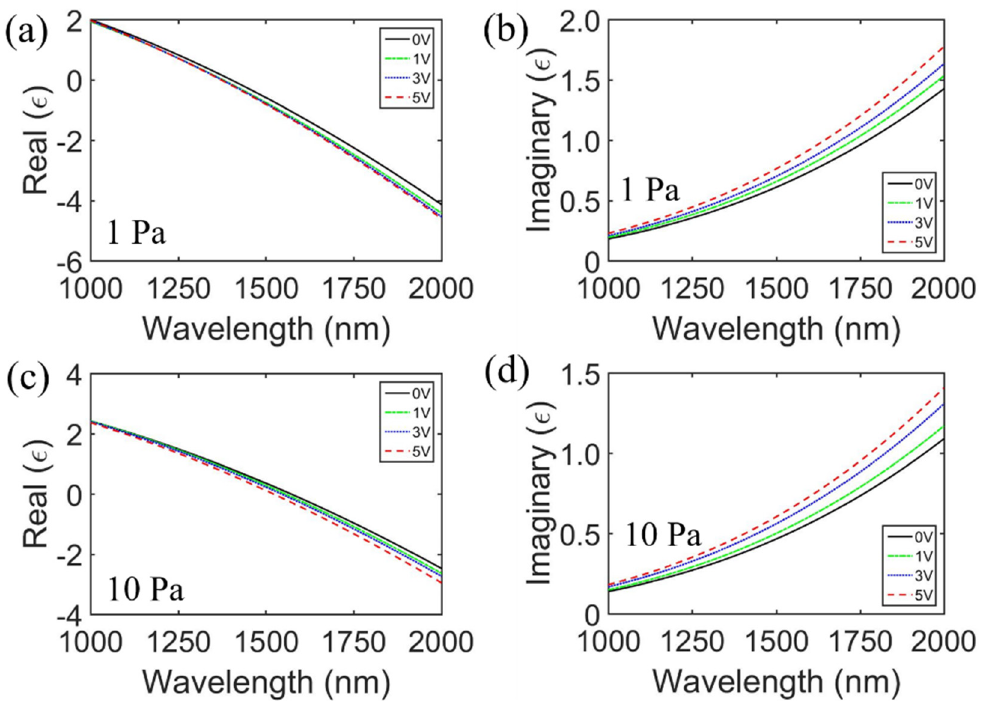
Figure 6. Real and imaginary permittivity of ITO films deposited under an oxygen partial pressure of 1 ( a,b ) and ( c,d ) 10 Pa for different applied voltages with wavelengths ranging from 1000 to 2000 nm. ( a , b ) and ( c , d ) 10 Pa for di ff erent applied voltages with wavelengths ranging from 1000 to 2000